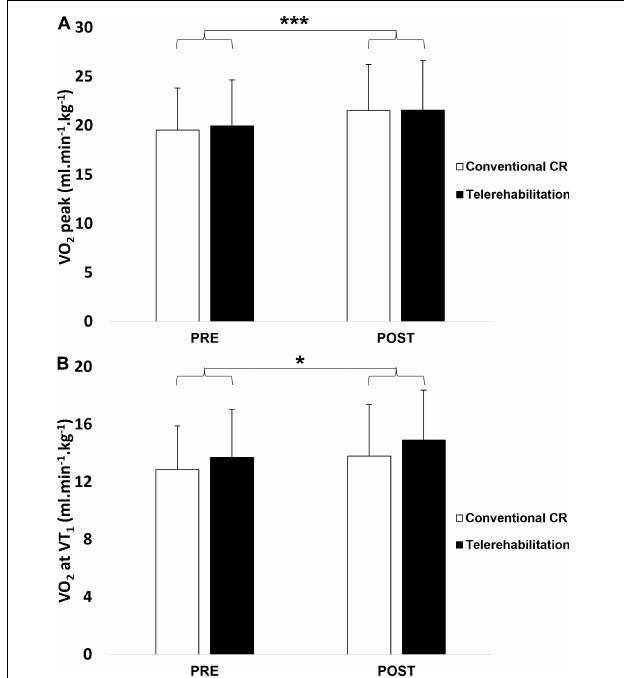
FIGURE 4 | Peak oxygen uptake (A) and oxygen uptake at the first ventilatory threshold (B) before and after a 3-week exercise program between telerehabilitation (black bars) and conventional CR (white bars) groups. CR, cardiac rehabilitation; VO 2 peak, peak oxygen uptake; VO 2 at VT 1 , oxygen uptake at the first ventilatory threshold. *Significantly difference between baseline ( p < 0.05); ***significantly difference between baseline ( p <